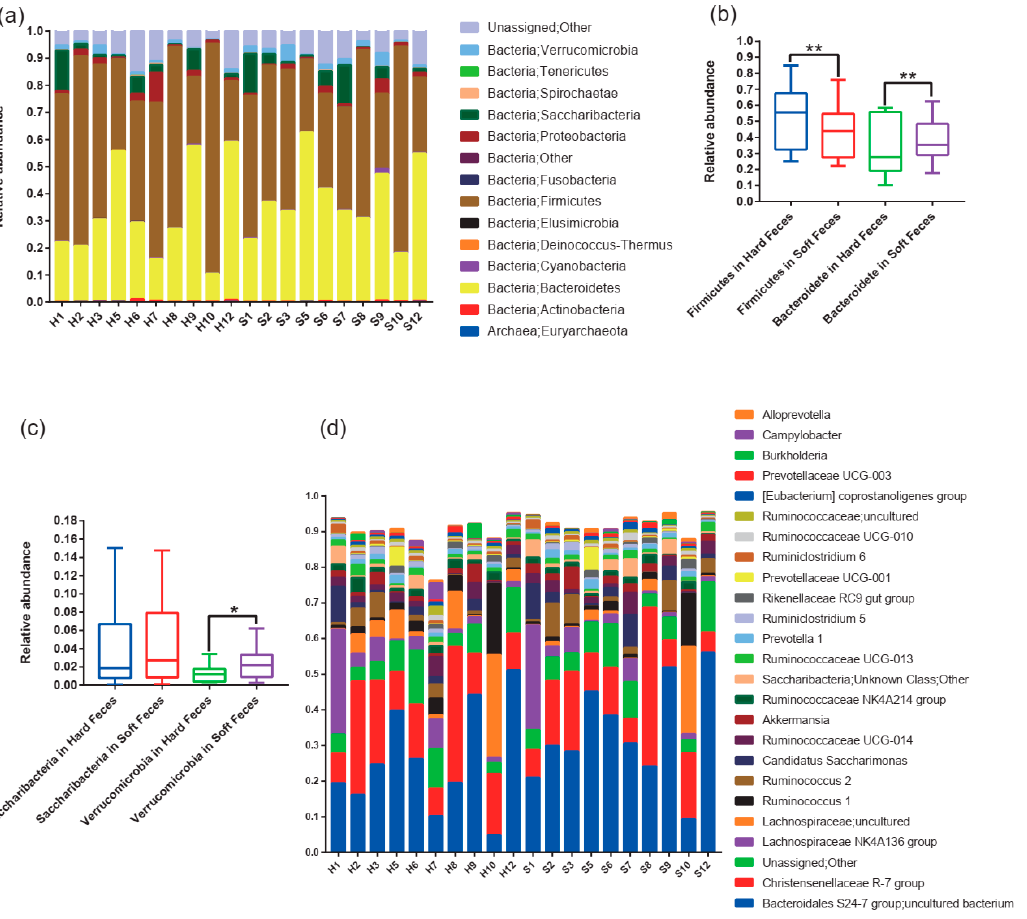
Figure 2. Composition of gut microbiota of hard feces and soft feces in plateau pikas. ( a ) Relative abundance of gut microbiota taxa at phylum level. ( b , c ) The dominant phyla; asterisks indicate the levels of statistical significance (Wilcoxon rank-sum test: ** p < 0.01, * p < 0.05). ( d ) The relative abundance of top 25